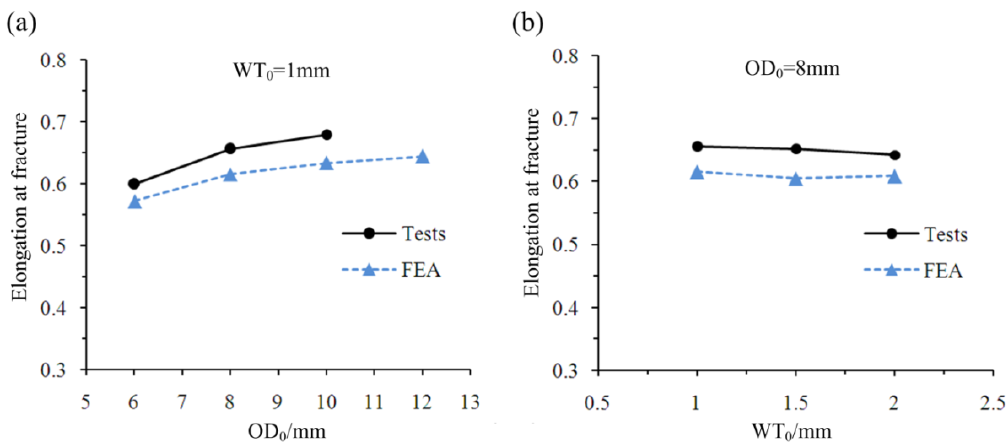
Figure 13. Effect of ( a ) original diameter and ( b ) original wall thickness on the elongation at fracture.